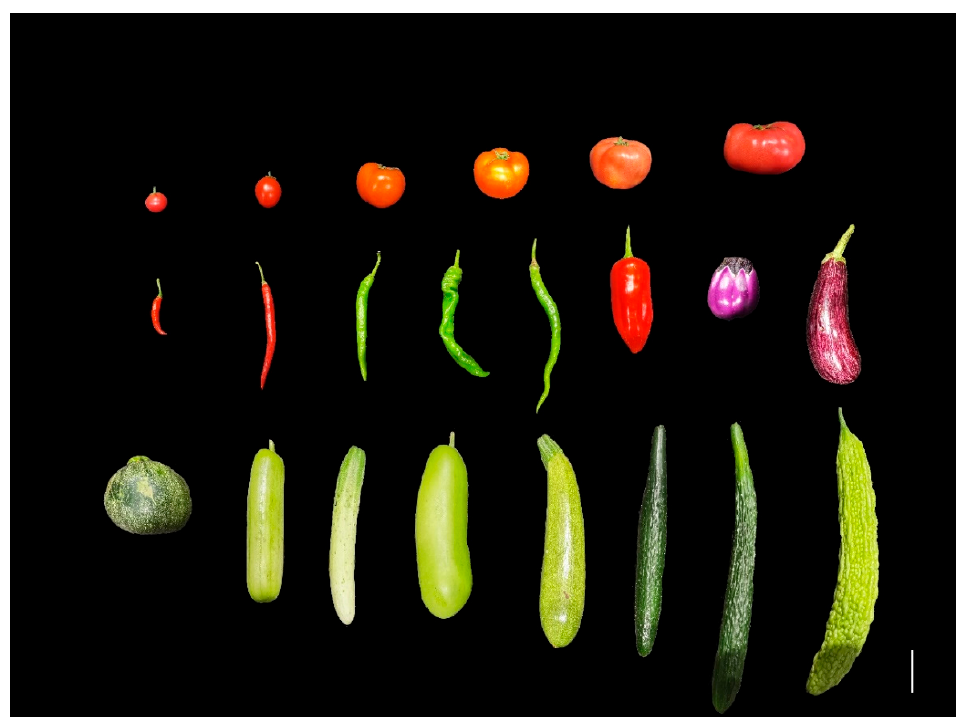
Figure 1. Diverse variations in fruit morphology of the Solanaceae and Cucurbitaceae families. Row one: Solanaceae; Row two: Solanaceae; Row three: Cucurbitaceae. Bar = 5 cm.